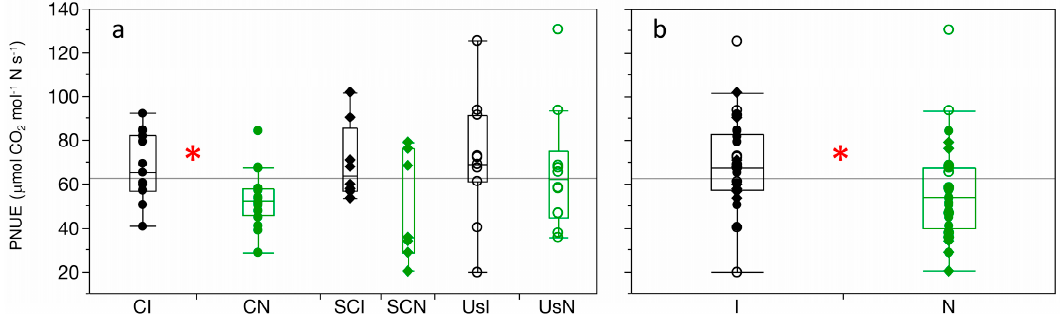
Figure 6. Comparison of photosynthetic nitrogen use-efficiencies for Castilla elastica = (I) (black symbols) and group of native species (N) (green symbols). The red asterisk indicates significant differences between groups of species (Wilcoxon and Wilcoxon/Kruskal-Wallis tests). ( a ) Photosynthetic nitrogen use efficiency per stratum and groups of species (CI > CN, Wilcoxon z value = 2.66, p = 0.0078) and ( b ) comparison between I and N (Wilcoxon/Kruskal-Wallis χ 2 = 8.8, p > χ 2 = 0.0031).